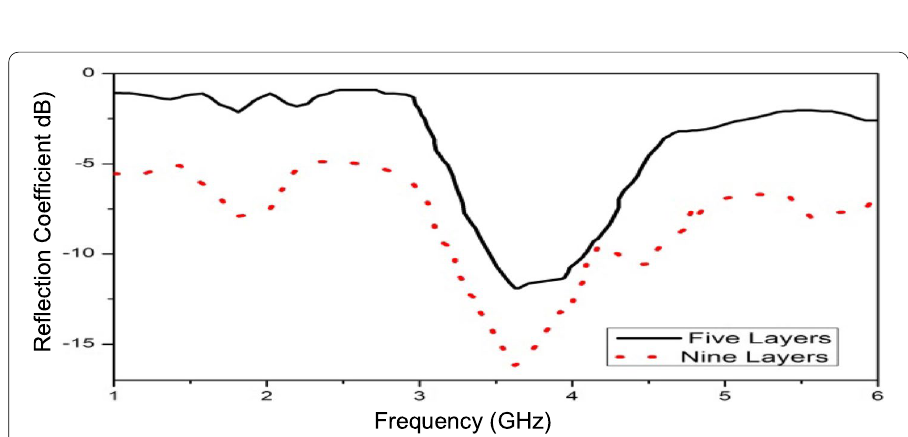
Fig. 13 Reflection coefficient of five and nine layers of SRR metamaterial-embedded